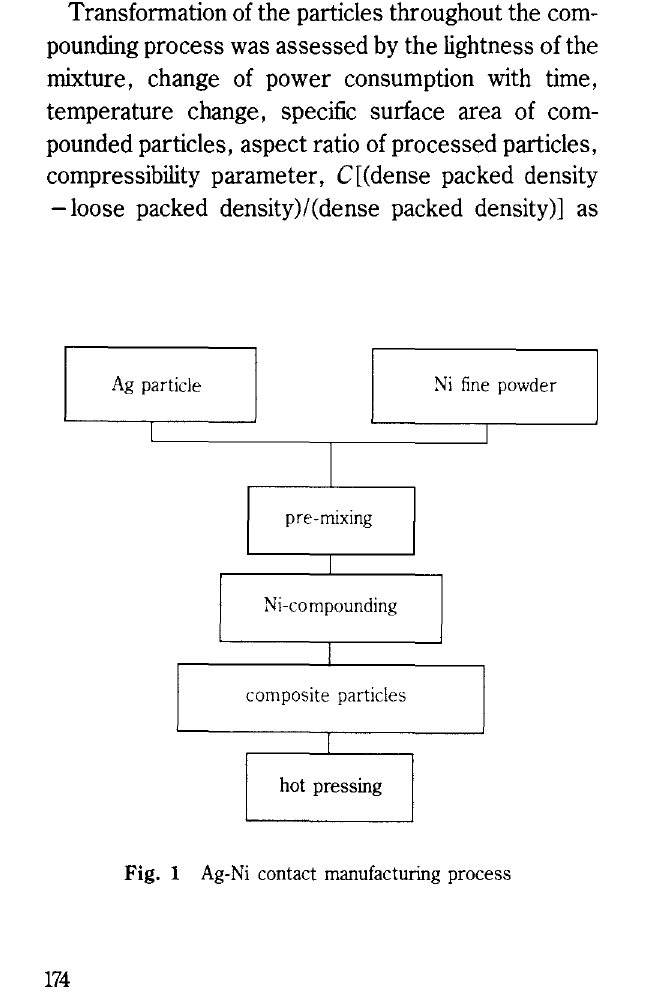
Fig. 2 Schematic illustration of high-speed/high-shear mill a flowability index, and SEM photograph.